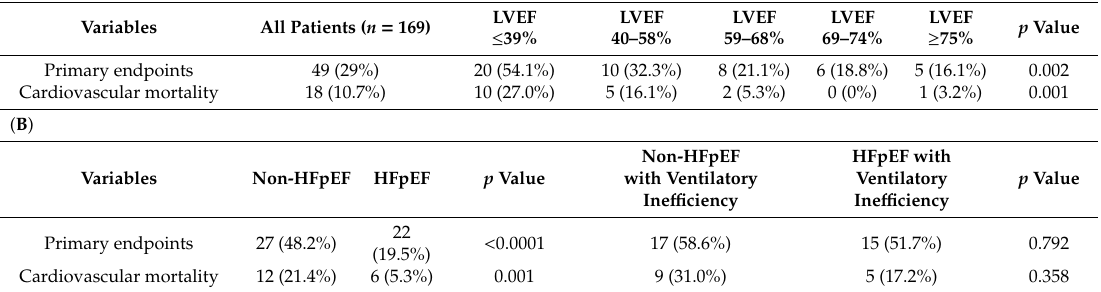
Table 2. ( A ) Outcomes by LVEF (5 groups); ( B ) outcomes between HFpEF and non-HFpEF without or with ventilatory ine ffi